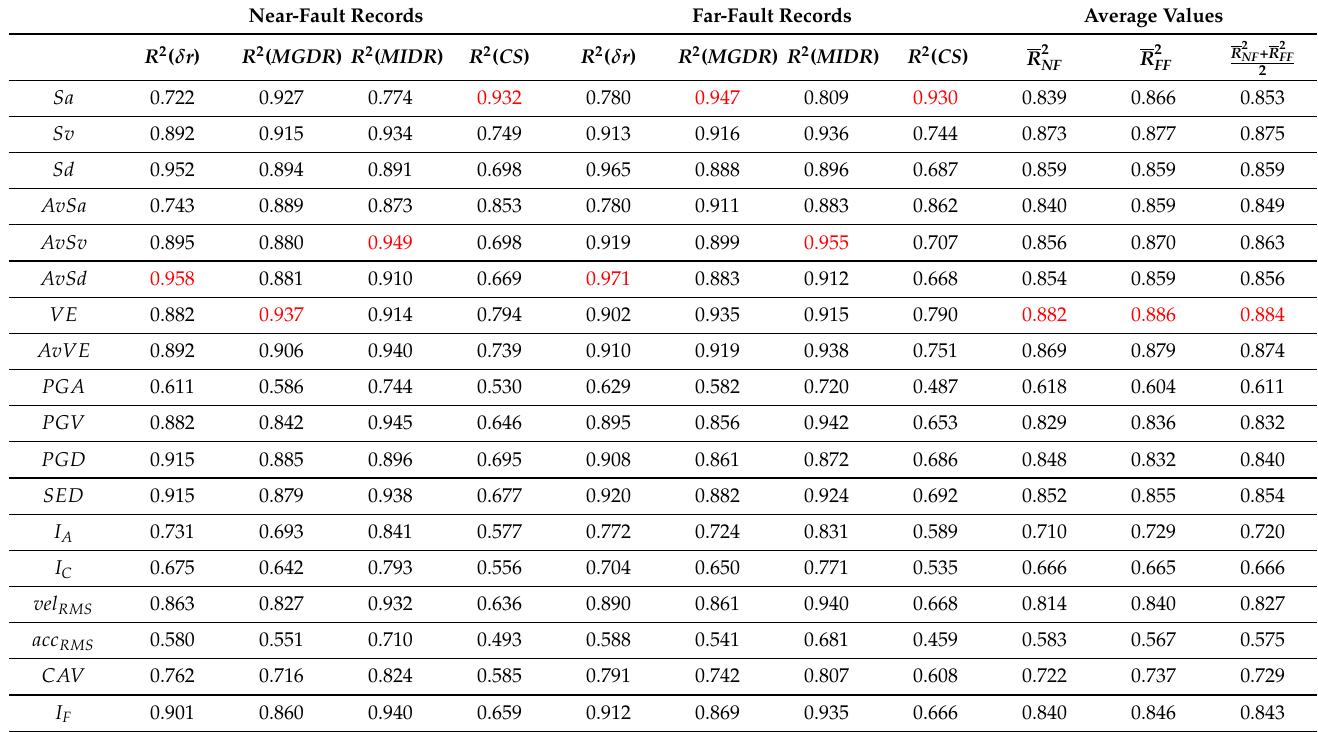
Table 3. Correlation index values. R 2 NF and R 2 FF are the average of the correlation index R 2 among all the EDPs analyzed for near-fault and far-fault records, respectively; the highest correlation values are highlighted in